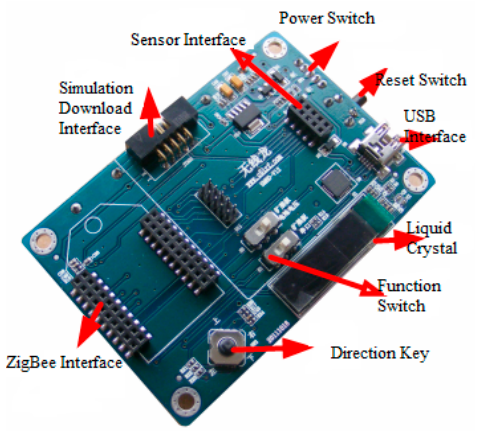
Figure 1. Sensor network node. Table 1. RSSI measurement range of four nodes at different